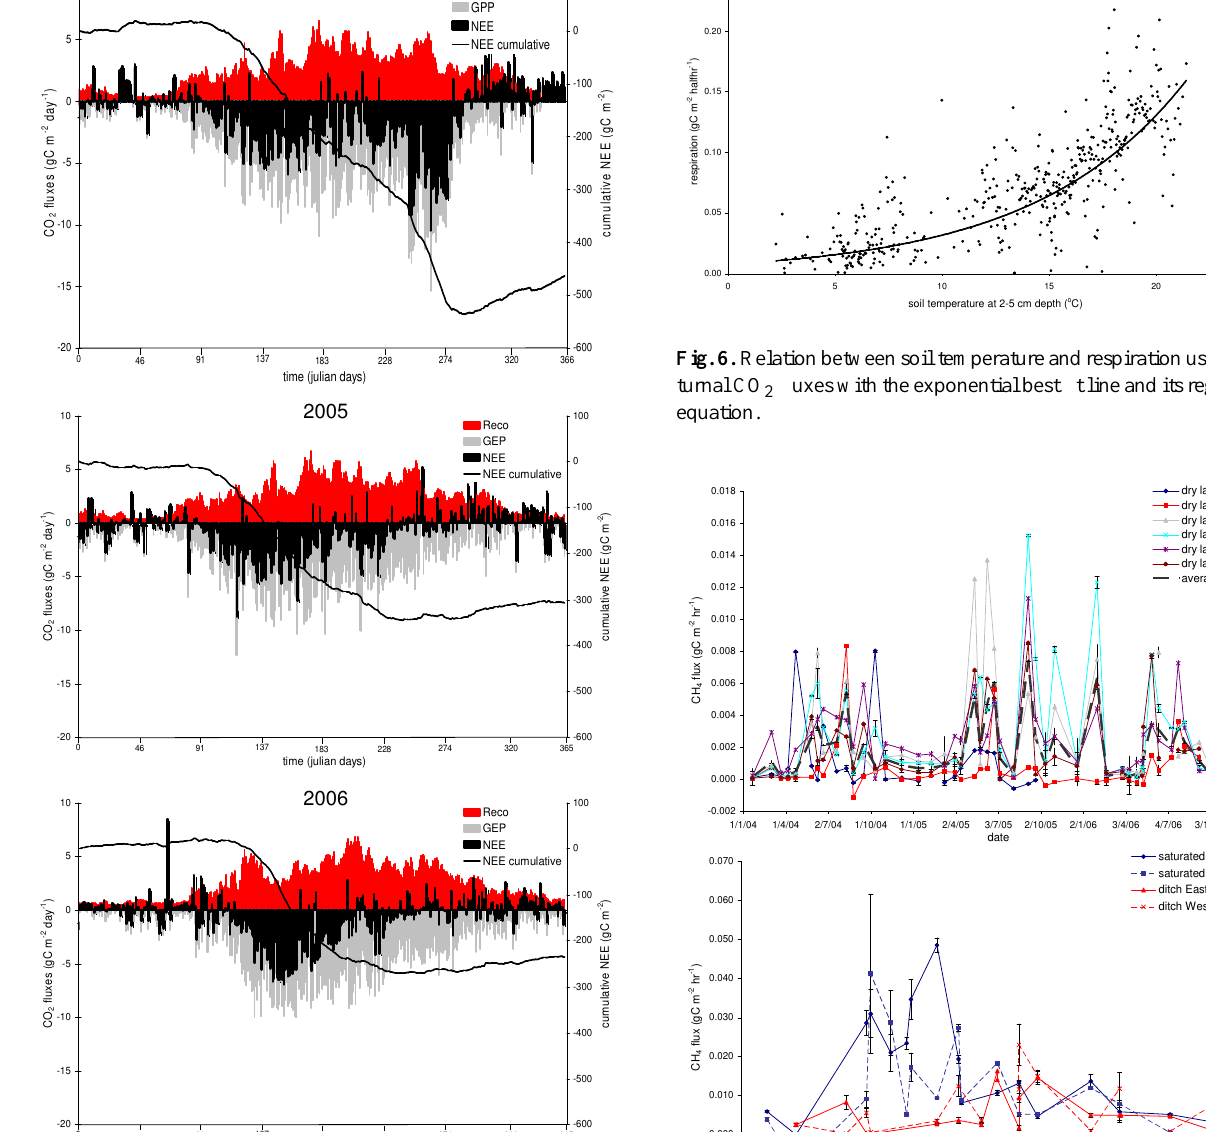
Figure 6: Relation between soil temperature and respiration using nocturnal CO 2 fluxes with the exponential best fit line and its regression equation.